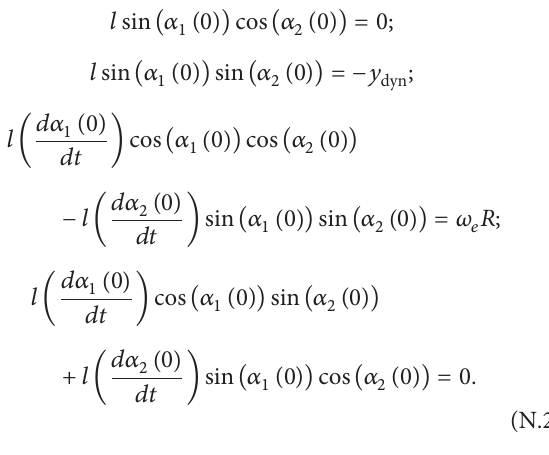
describing payload 𝑀 relative swaying in the case of